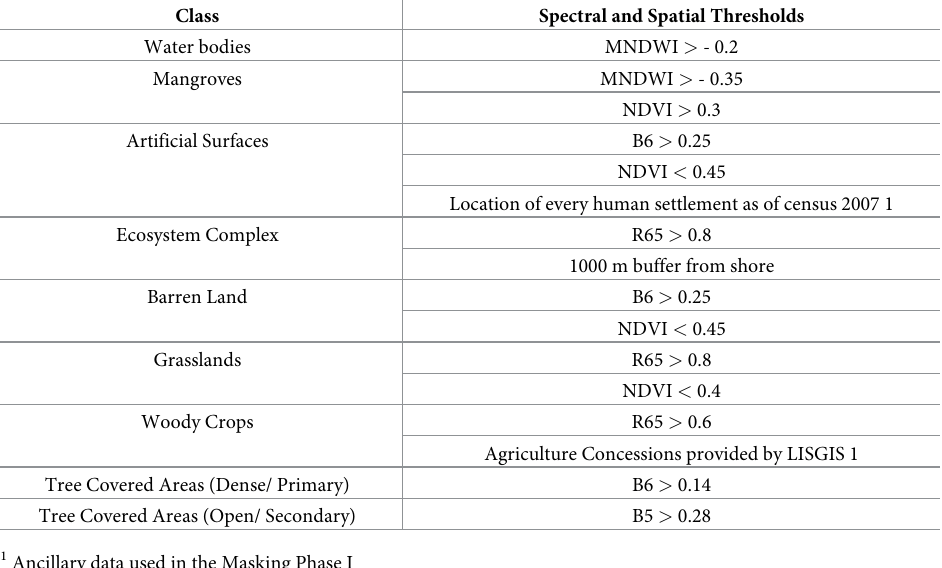
Table 4. Spectral and spatial thresholds for the pre-classification masking phase I and II for